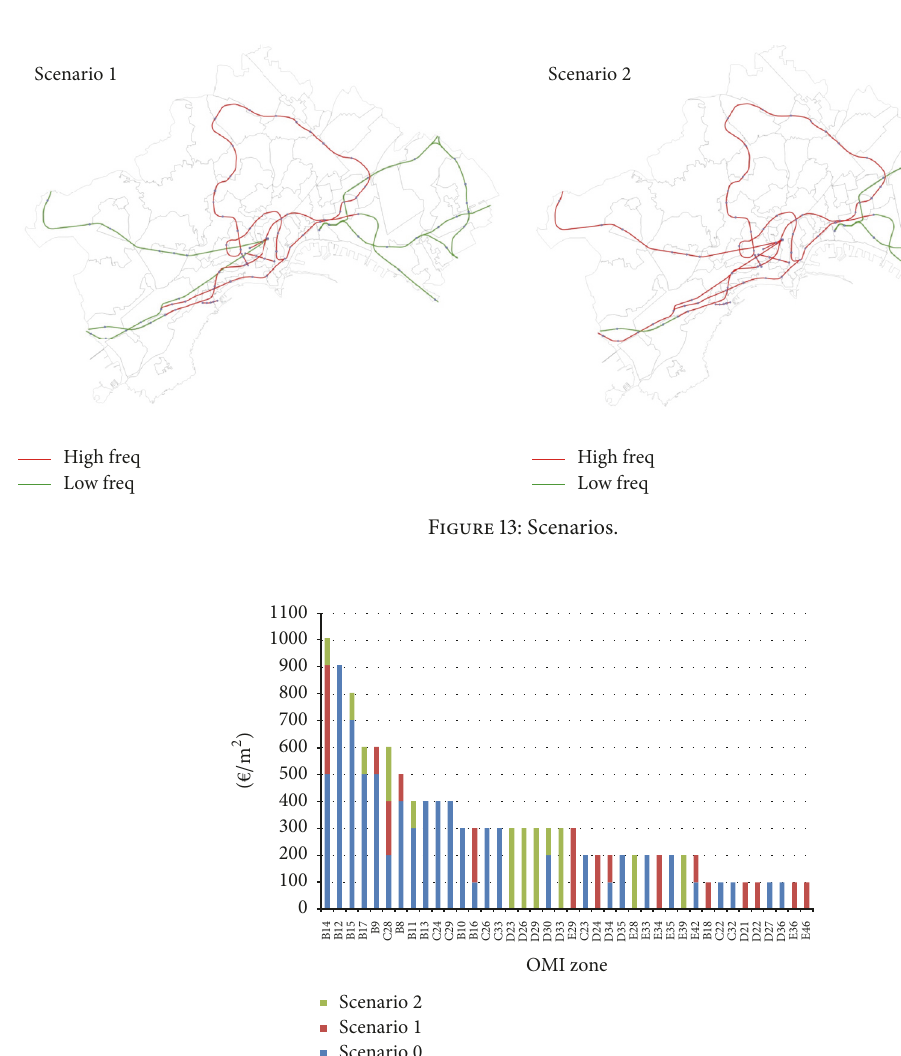
Figure 14: Contribution of high-frequency rail stations to real estate values for each